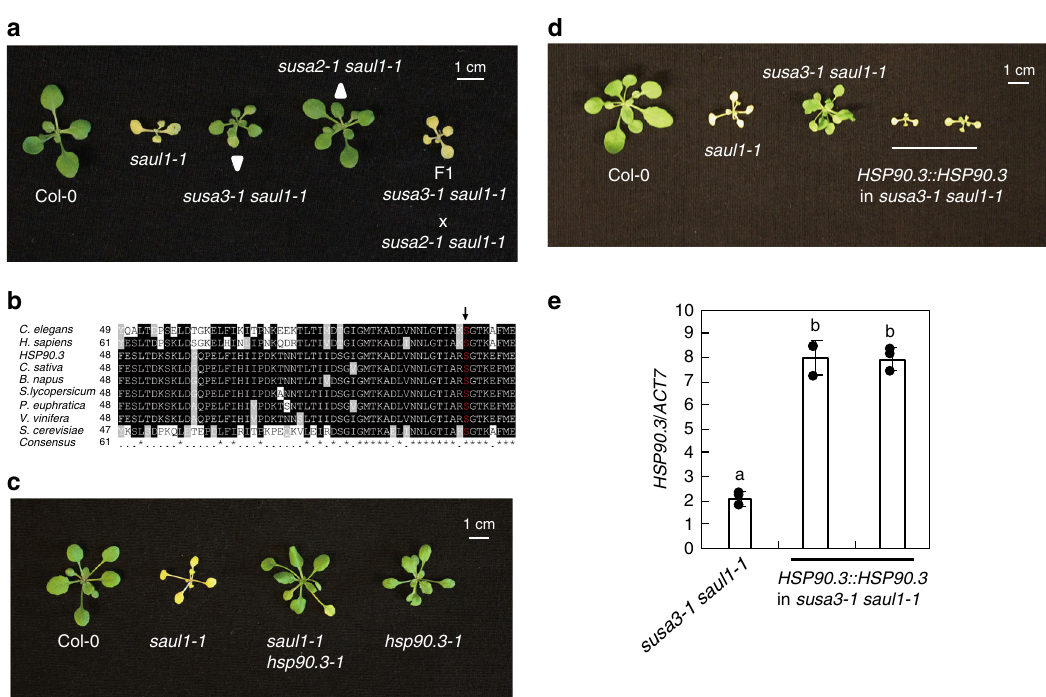
Fig. 3 Characterization and positional cloning of susa3-1 . a Morphology of 3.5-week-old Col-0, saul1-1 and susa3-1 saul1-1 , susa2-1 saul1- 1, and an F1 plant of susa3-1 saul1-1 crossed with susa2-1 saul1-1 . Plants were grown on 1/2 MS medium for 10 days and then transplanted to soil for 2 weeks before the picture was taken. b Part of the HSP90.3 protein alignment from multiple species. * indicates conserved amino acid. The arrow points to the mutated residue in susa3-1 . c Morphology of 3.5-week-old Col-0, saul1-1 and saul1-1 hsp90.3-1 , and hsp90.3-1 plants. Plants were grown on 1/2 MS medium for 10 days and then transplanted to soil for 2 weeks before the picture was taken. d Morphology of 3.5-week-old Col-0, saul1-1 , susa3-1 saul1-1 , and two independent transgenic plants with HSP90.3::HSP90.3 transformed into susa3-1 saul1-1 . Plants were grown on 1/2 MS medium for 10 days and then transplanted to soil for 2 weeks before the picture was taken. e HSP90.3 expression in the indicated plants in d as determined by RT-PCR and normalized to ACT7 . Error bars represent means ± SD (one-way ANOVA, SPSS Statistics, n = 3, p < 0.01). Experiments were repeated three times with similar